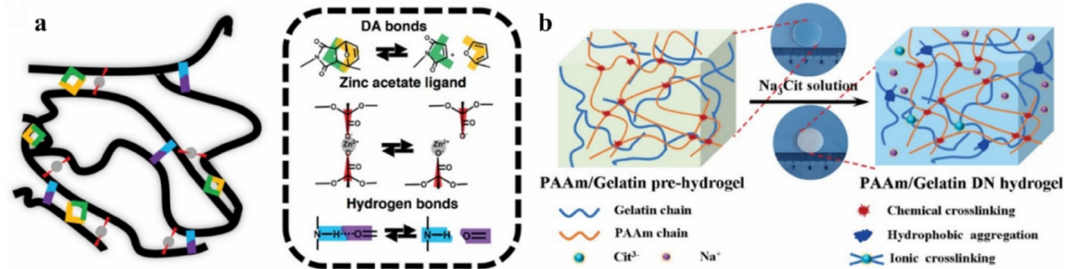
Figure 57. ( a ) Hybrid dynamic network containing triple dynamic bonds, including reversible covalent bonds, zinc–ligand and H-bonds. Reproduced from [238] with permission from John Wiley and Sons. ( b ) Schematic representation of PAAm-Gelatin DN hydrogel. Reproduced from [239] with permission from John Wiley and